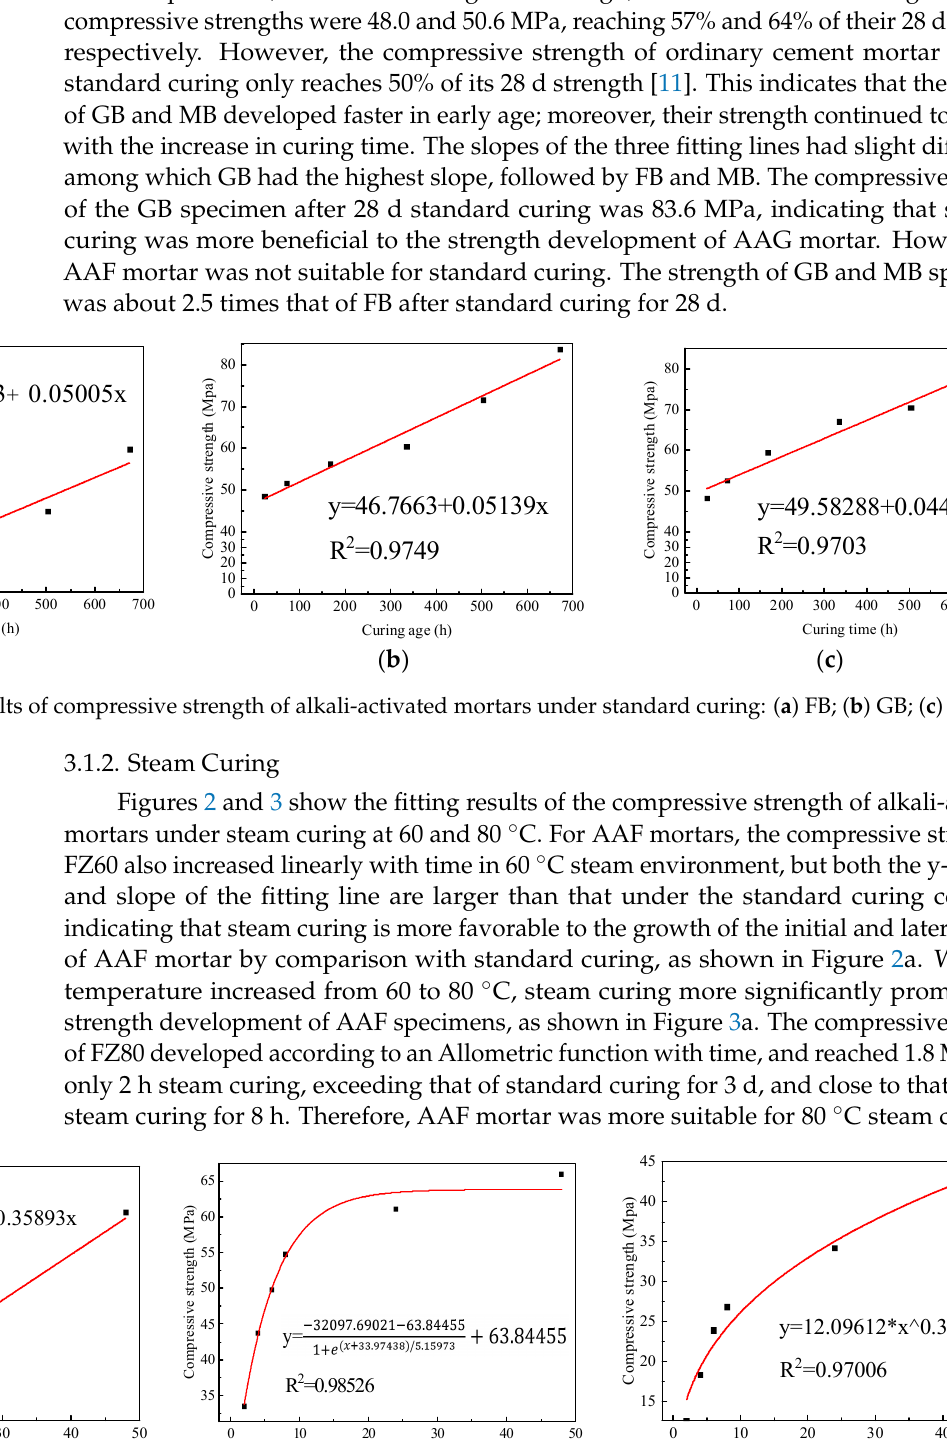
( c ) Figure 3. Fitting results of the strength of alkali-activated mortars under steam curing at 80 °C: ( a ) FZ80; ( b ) GZ80; ( c ) MZ80. For AAM mortar, the compressive strength developed according to an Allometric function with time under both 60 and 80 °C steam curing conditions, as shown in Figures 2c and 3c. Their strength increased rapidly, not only in the first 8 h, but also in the later period. The effect of curing temperature on the strength of AAM mortar was similar to that of the other alkali-activated mortars. By comparing the sensitivity of the three alkali-activated mortars to steam curing, it was found that the strength of AAG mortar developed the fastest in the first 8 h but in- creased little thereafter, whereas the strength of AAF and AAM mortars still underwent a substantial rise in 8–48 h. Therefore, it is suggested that 80 °C steam curing should be adopted to increase the early strength of alkali-activated mortars. Regarding AAG mor- tar, the steam curing time should be controlled within 12 h to reduce energy consump- tion; for AAF and AAM mortar, the steam curing time can be appropriately extended to promote the development of strength. 3.1.3. Oven Curing Oven curing is also called dry curing, and the essential difference from steam curing is that the relative humidity in the oven is very low. The fresh mortars were first cured under the steam condition for 6 h to form certain strength, and then moved to the oven for further curing. From Figure 4 it can be seen that, in the first 6 h, the compressive